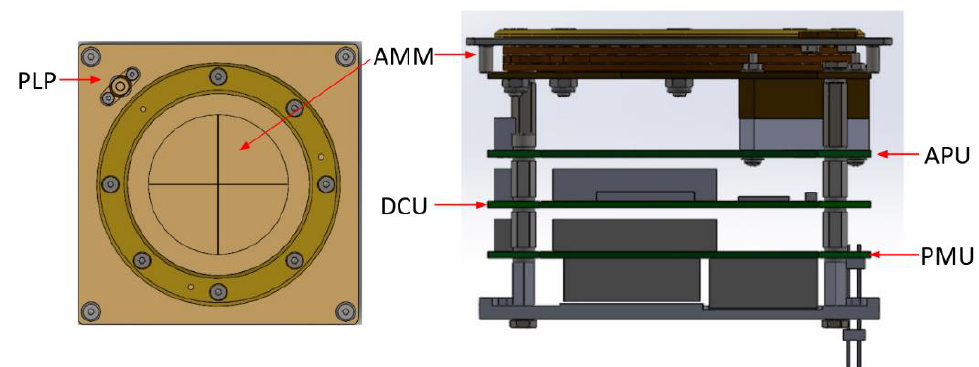
Figure 2. CIP mechanical structure, comprised of the apertures and meshes module (AMM), analog preprocessing unit (APU), digital control unit (DCU), and power management unit (PMU).